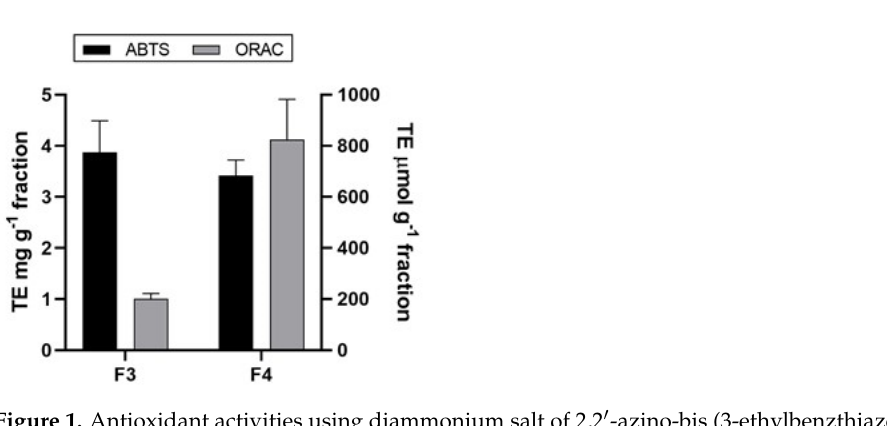
Figure 1. Antioxidant activities using diammonium salt of 2,2 ′ -azino-bis (3-ethylbenzthiazolin-6- yl) sulfonic acid (ABTS) and oxygen radical absorbance capacity (ORAC) assays of the polarity fractions from A. rigida . The values are mean values ± standard deviations ( n = 3).